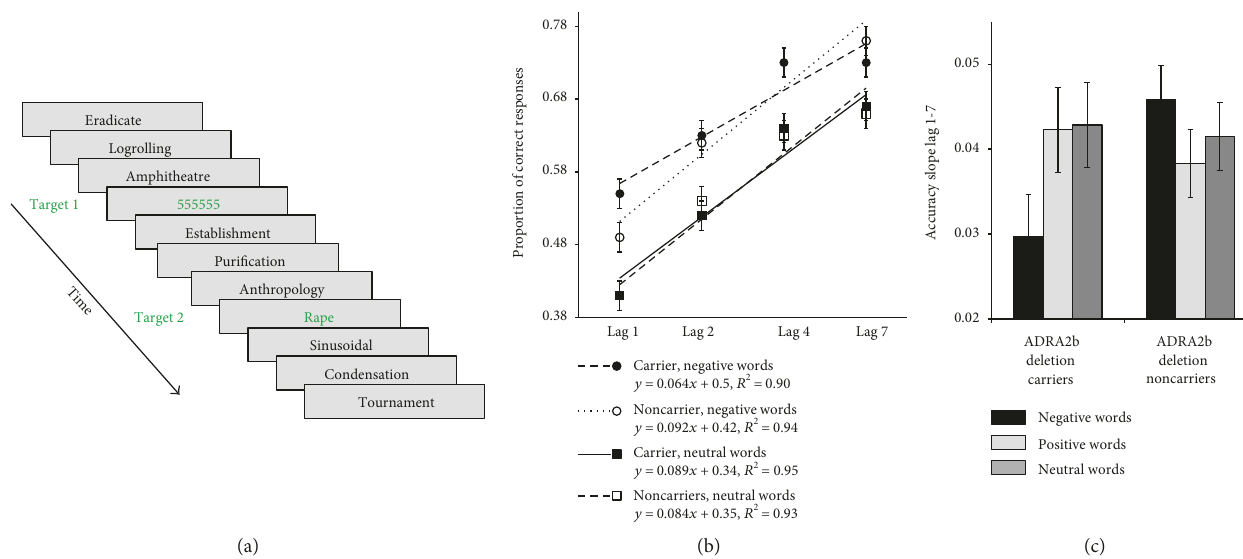
Figure 3: (a) Sample trial in attentional-blink (AB) task. Two targets were presented among several distractors: target 2 was a positive, negative, or neutral word. It was presented after target 1 after zero (Lag 1), one (Lag 2), three (Lag 4), or six (Lag 7) distractors. At the end of each trial, participants had to report both targets. (b) Proportion of correct responses for ADRA2b deletion carriers and noncarriers as a function of the lag between the two targets and emotion category. (c) The slope for accuracy from Lag 1 to Lag 7 as a function of group and emotion category. Adapted from “ Genes for emotion-enhanced remembering are linked to enhanced perceiving ” by Todd et al. [41]. Copyright 2013 by Sage